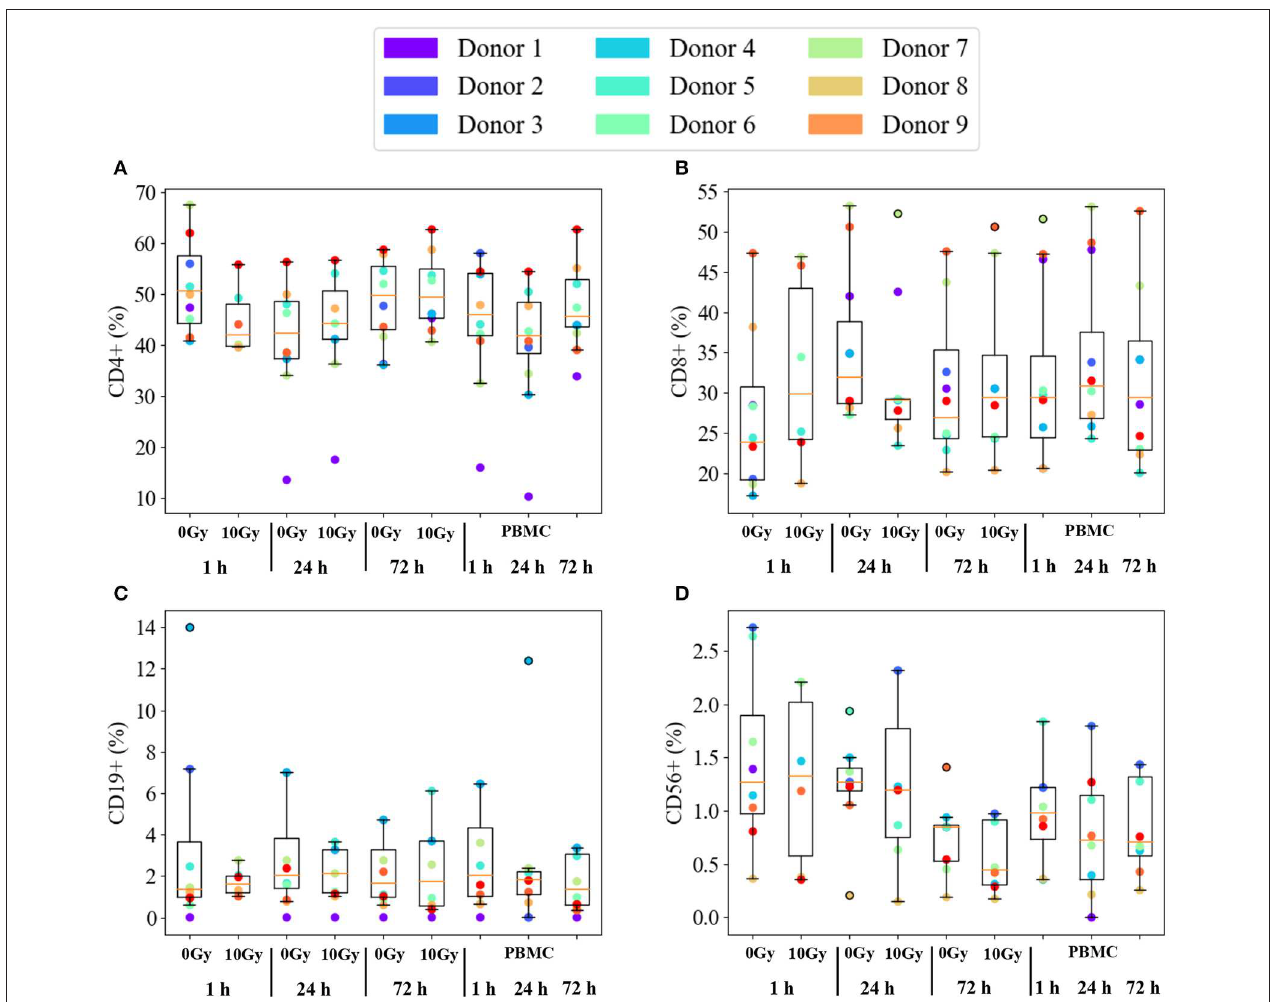
FIGURE 3 | Immunophenotyping of PBMCs from individual donors. Subset population percentages for: (A) helper T cells (CD4 + ); (B) cytotoxic T cells (CD8 + ); (C) B lymphocytes (CD19 + ); (D) NK cells (CD56 + ). Experimental conditions are: PBMCs cultured alone or in co-culture with sham- or 10 Gy-irradiated Caco-2 cells, at the time-points: 1, 24, and 72h. Colored dots are individual data. The median value is indicated by the red horizontal bar, the box is drawn from the first to the third quartile, with whiskers extending to the most extreme data points not considered outliers. Outliers (outside the + / − 2.7 σ if data were normally distributed around the median) are plotted individually. Due to limited yields of extracted PBMCs not all conditions are present for each of the 9 donors.